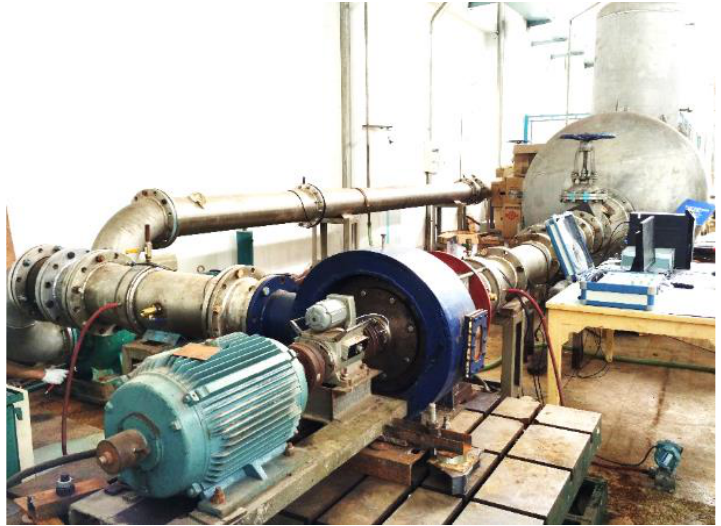
Figure 3. Experimental setup.